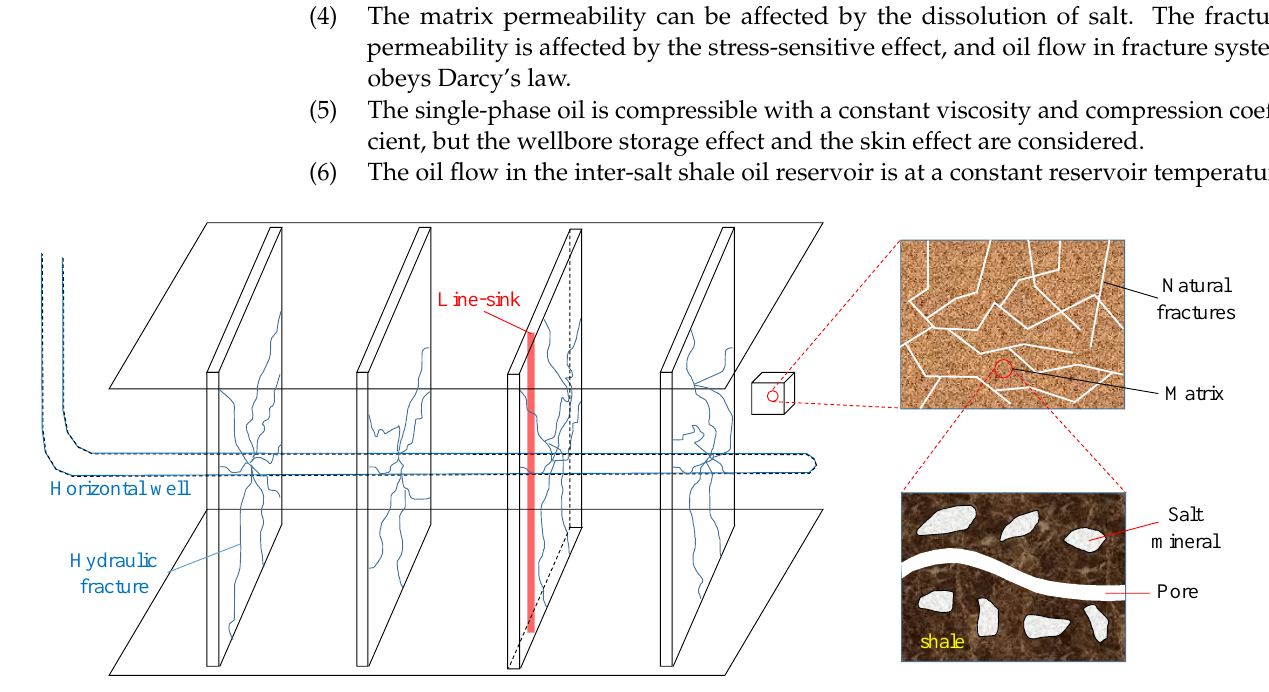
Figure 1. Physical model of a MFHW in an inter-salt shale oil reservoir.